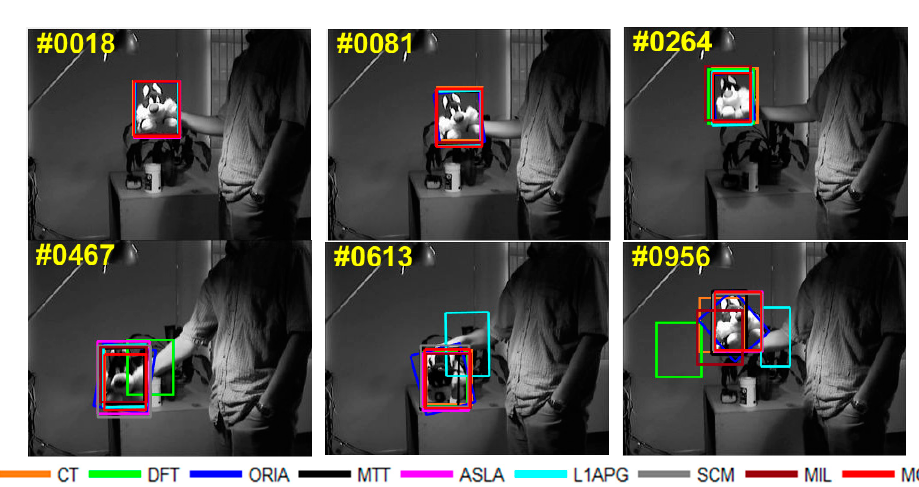
Figure 14. Tracking results on Sylvester .